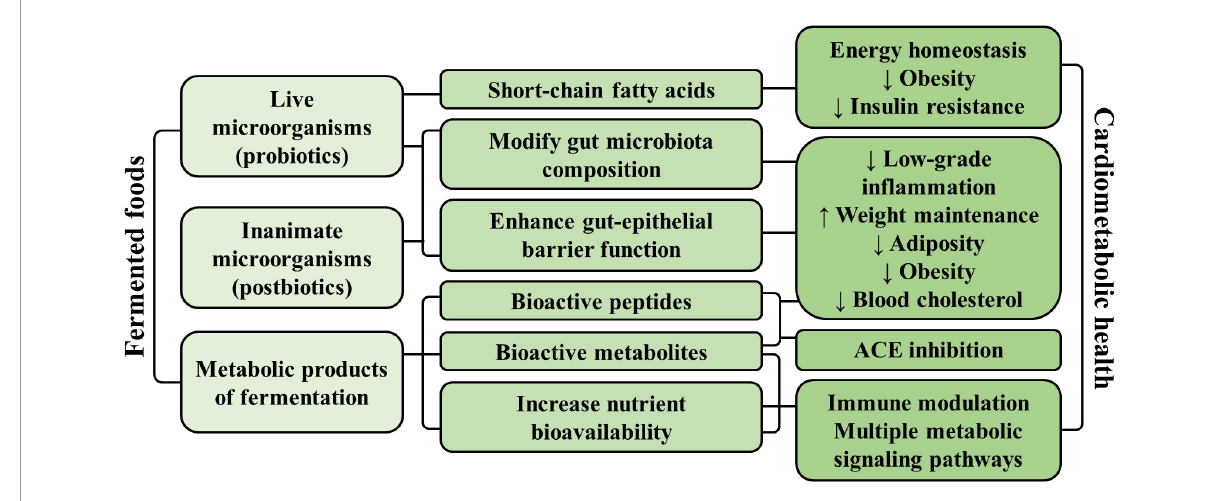
FIGURE2 Summary of the main proposed mechanisms by which fermented foods may promote cardiometabolic health.